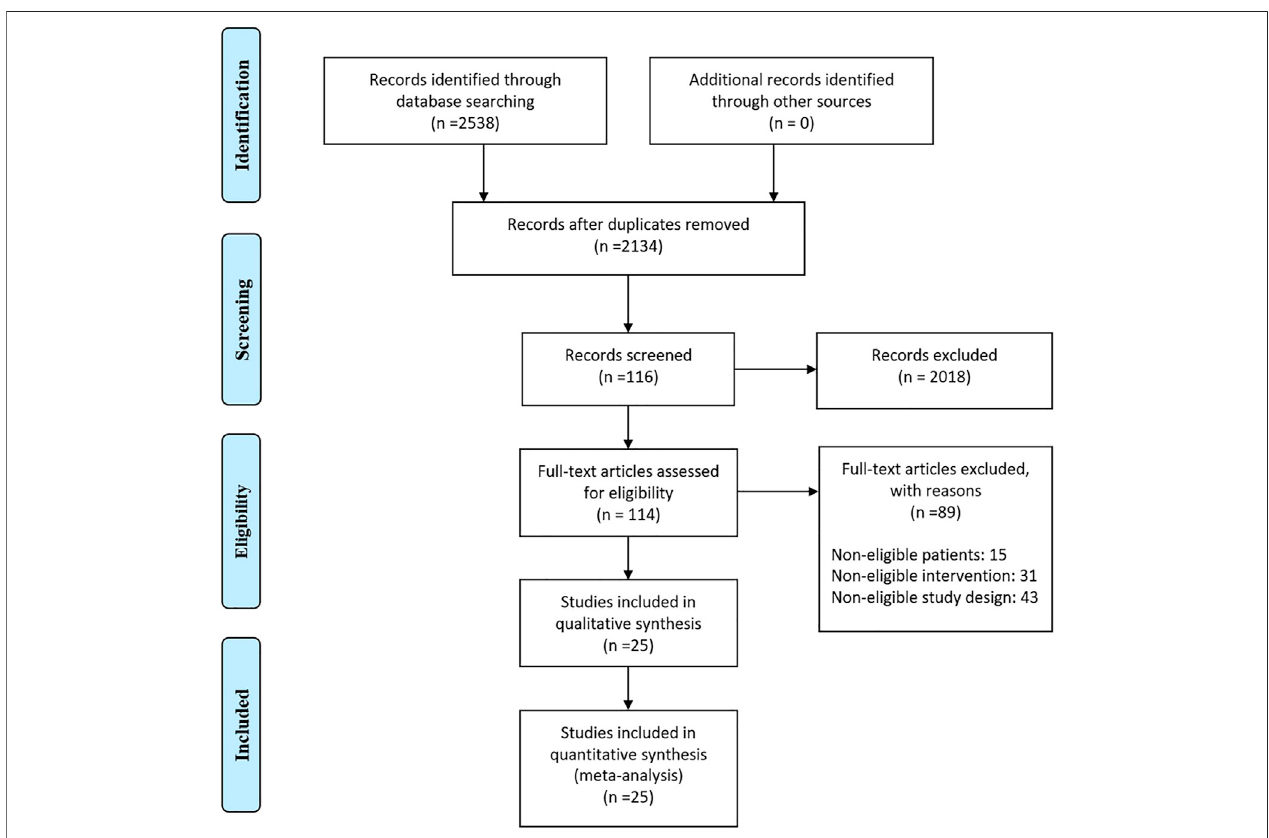
FIGURE 1 | Flow chart indicating the selection process for this network